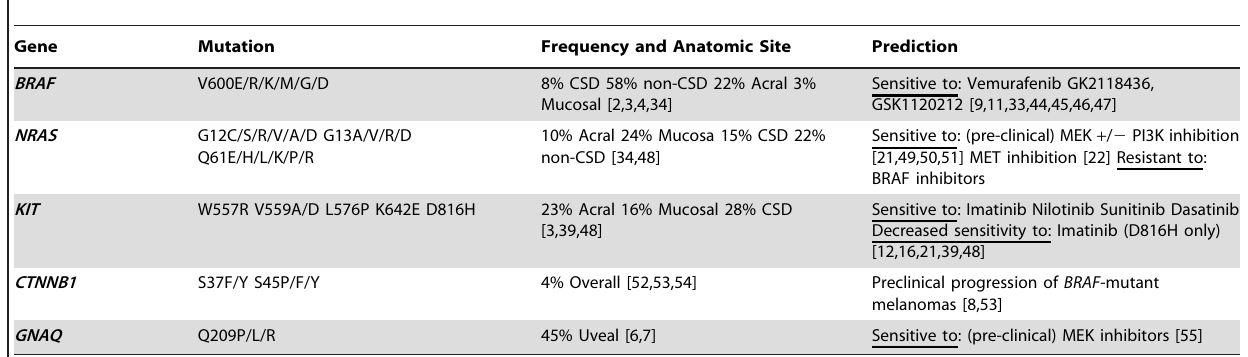
Table 1. Gene mutation frequency in melanoma and predicted sensitivities to targeted.